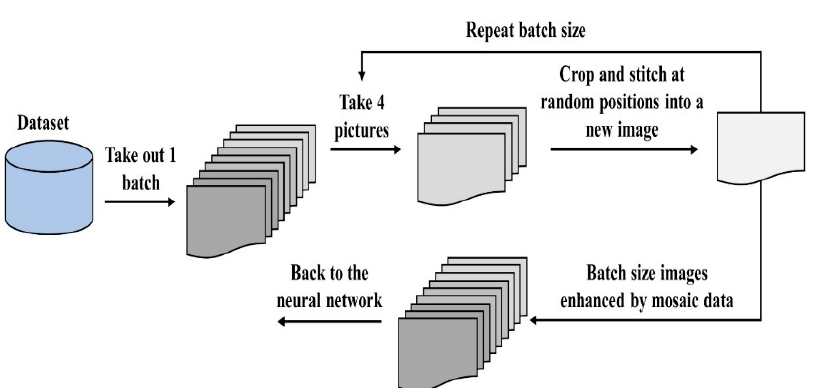
Figure 4. Mosaic data enhancement.